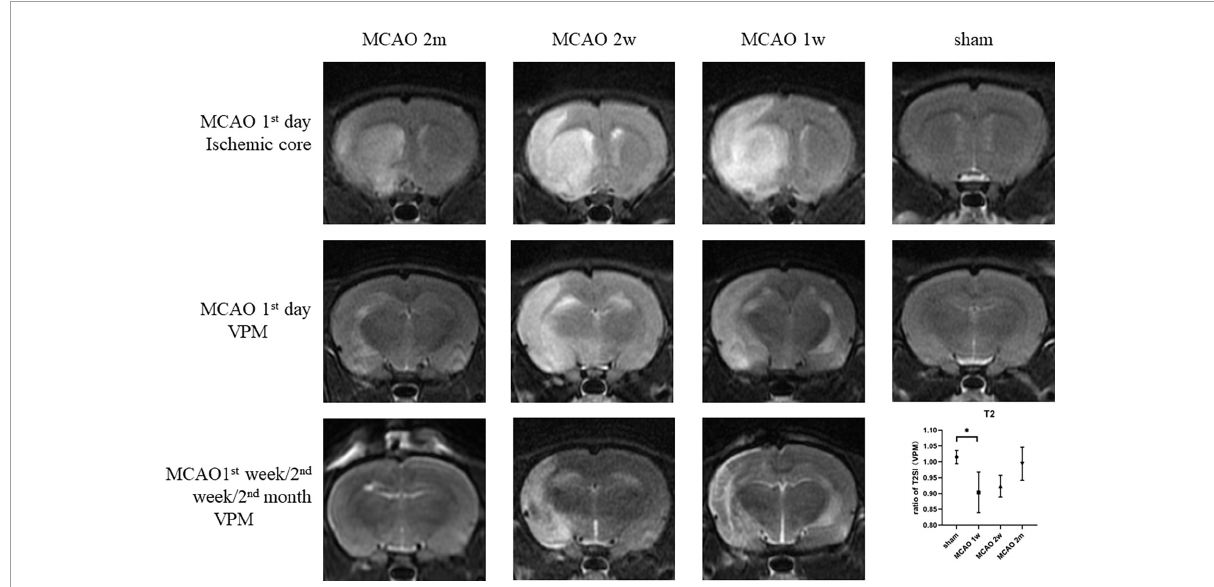
FIGURE7 The T2SI of the ischemic cores and the ipsilateral thalamus VPN. On the 1st day after MCAO, the ischemic lesions were high signal at T2-weighted MRI for MCAO 2 month group, MCAO 2 week group, and MCAO 1 week group. The ratio of T2SI of the ipsilateral thalamus VPN touched bottom at the 1st week after MCAO and gradually recovered at the 2nd week and the 2nd month. T2SI, T2 signal intensity; VPN, ventroposterior nucleus; MCAO, middle cerebral artery